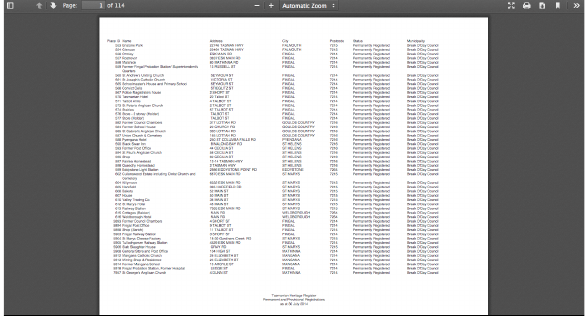
Figure 1. Tasmanian Heritage Register is a simple spreadsheet